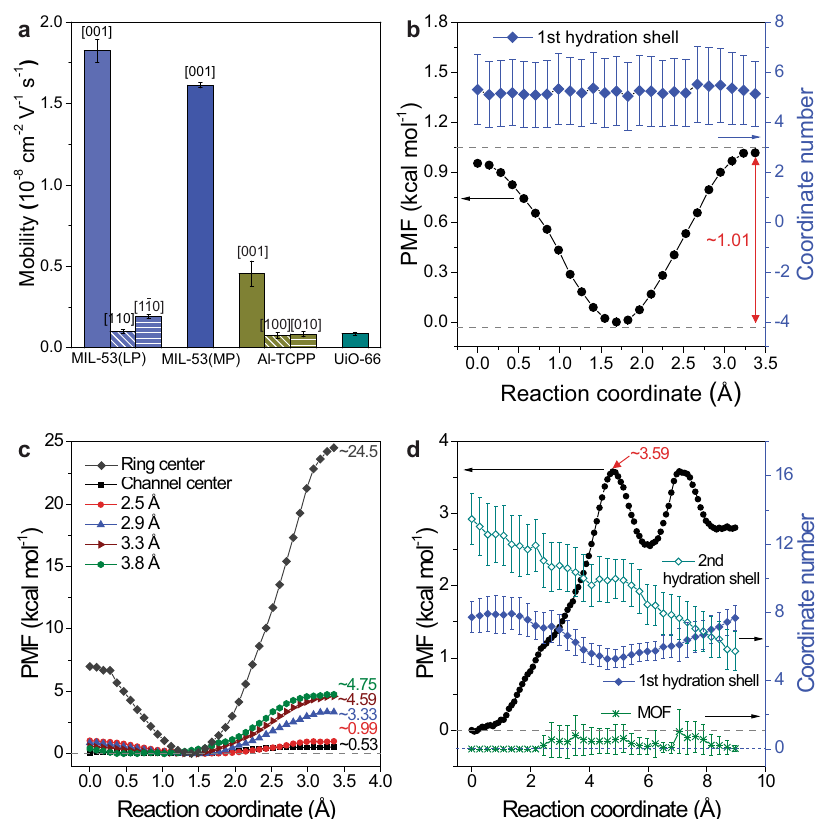
Fig. 5 | MD simulations of ion transport properties in MOF channels. a Electro- mobilities of K + calculated from MD simulations in different MOF channels and E - fi eld directions. Error bars represent the standard deviation of calculations. Note that UiO-66 channel exhibits the same ion transport property in three directions attributed to the symmetry of the cubic crystal system. Thus, the E - fi eld along the [111] direction was investigated in the UiO-66 cells. b The PMF curve and fi rst shell water hydration number of MIL-53(MP) channel. c The PMF curves of Al-TCPP channel atdifferent channel positions. Note thatthe colored linesmarkthe pro fi le